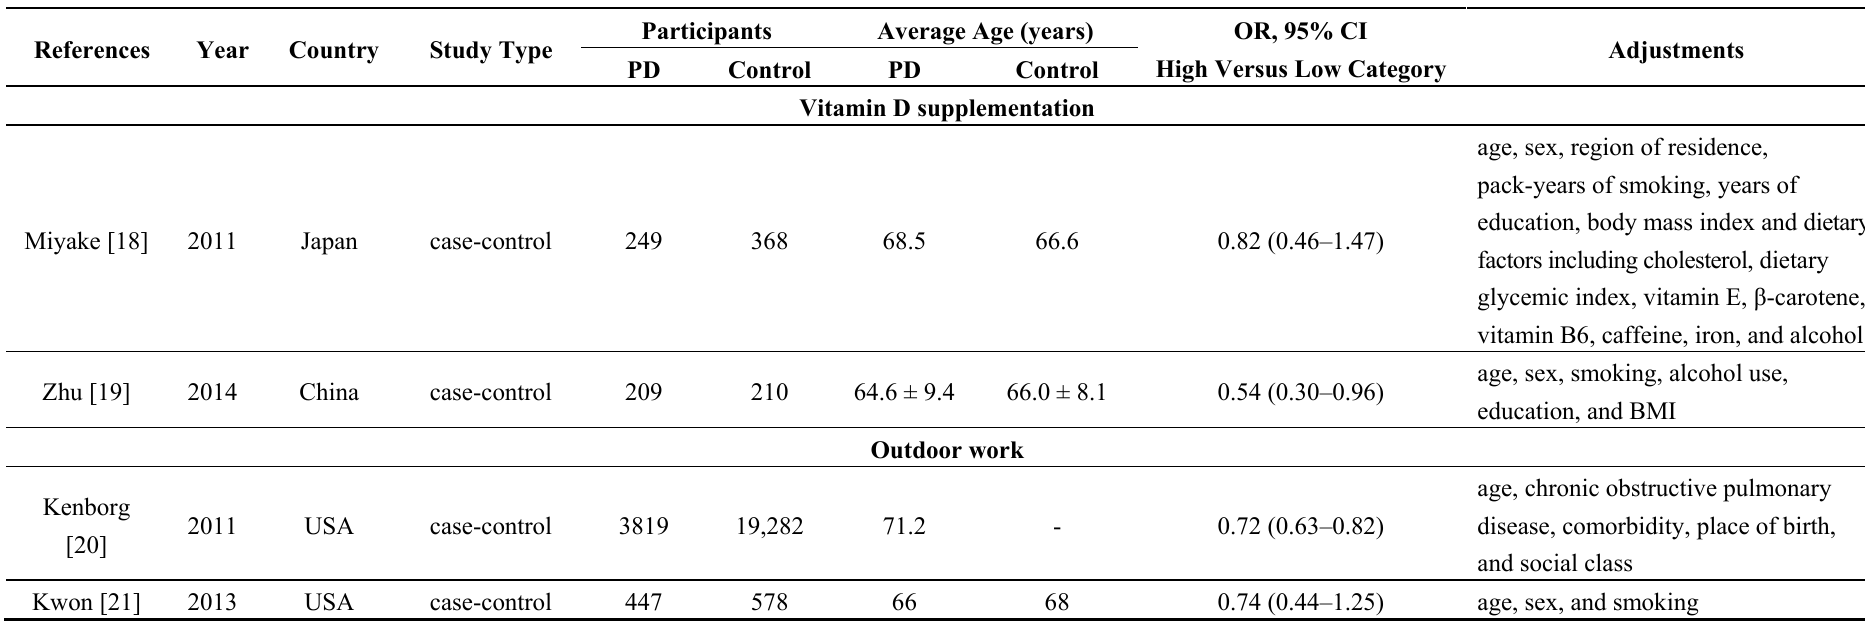
Table 2. Main characteristics of eligible studies for the analysis of vitamin D supplementation, outdoor work and risk of